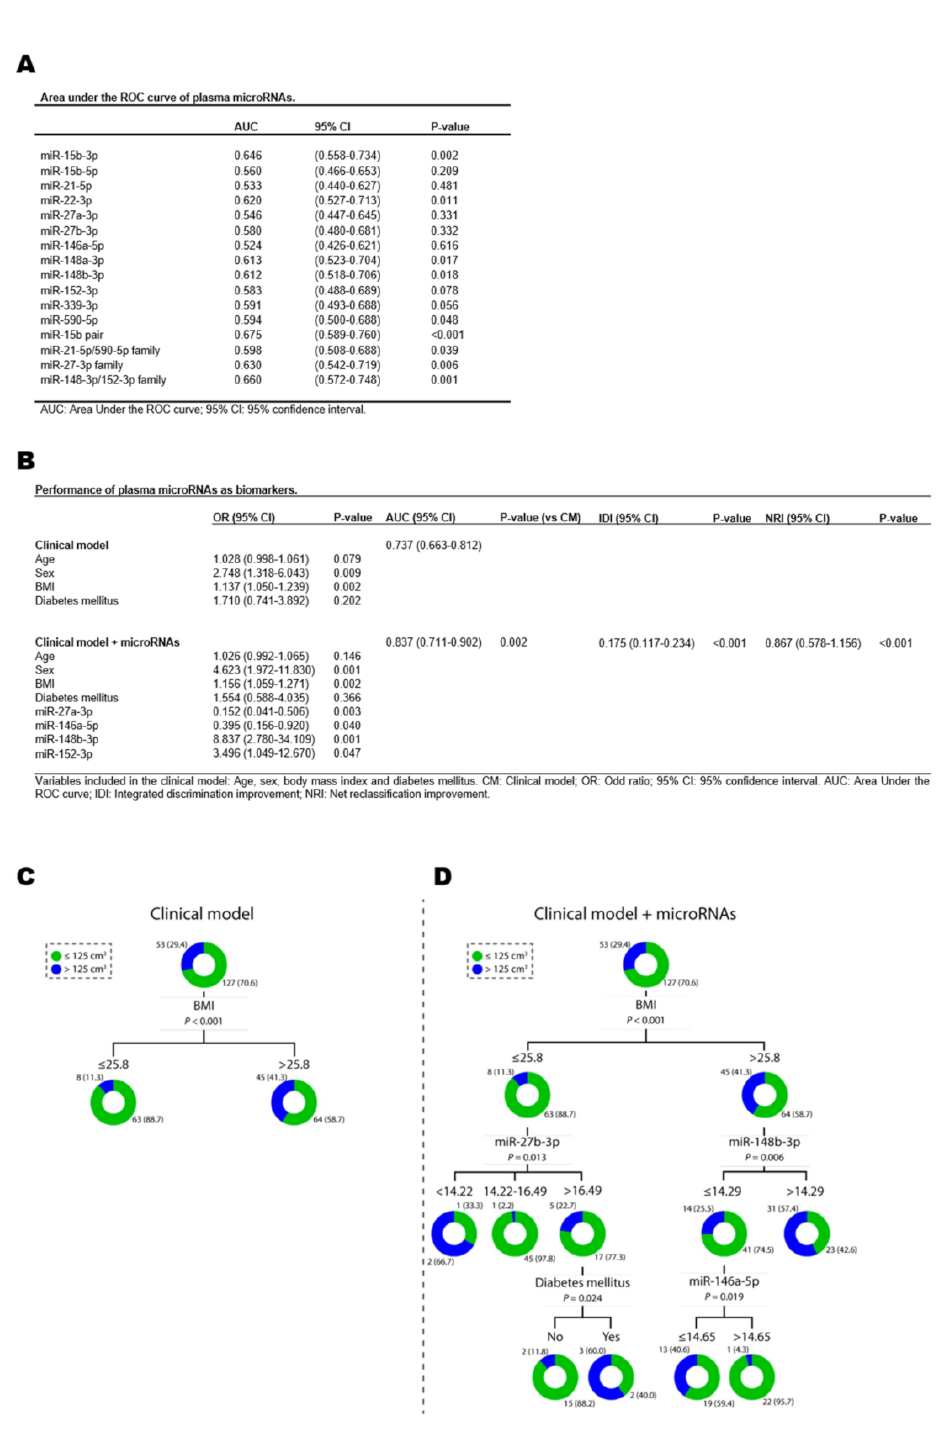
Figure 4. Plasma microRNAs (miRNAs) as biomarkers of epicardial fat volume, according to the cutoff values proposed by Spearman et al. [15]. ( A ) Area under the ROC curve (AUC) for each individual miRNAs and for combinations of miRNAs in pairs or families. ( B ) Performance of plasma miRNAs as biomarkers. ( C , D ) Decision trees calculated by Chi-squared Automatic Interaction Detector (CHAID) algorithm. The following variables were included in the clinical model: age, sex, body mass index and diabetes mellitus. MicroRNA levels were log 2 -transformed. For logistic regression models, data are presented as an odds ratio (OR) and 95% confidence intervals (CI). For discrimination analysis, data are presented as the AUC and 95% CI. For reclassification analysis, data are presented as the Integrated Discrimination Improvement (IDI) index and Net Reclassification Improvement (NRI) index and their respective 95% CI. For decision trees, data are shown as frequency (percentage) of patients in each study